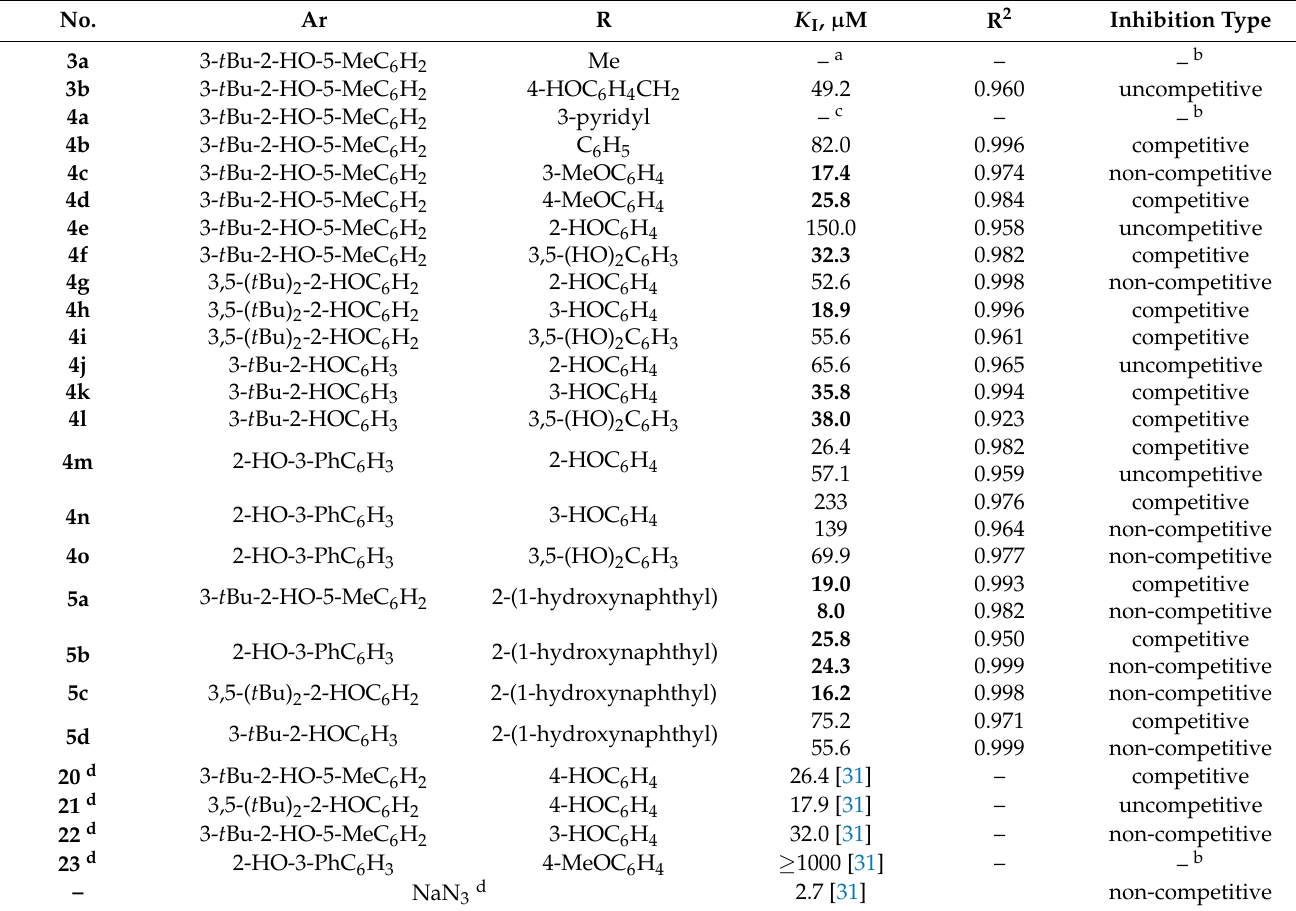
Table 2. Structures and inhibition constant ( K I , µ M) values of the hydrazide-hydrazones 3a – b , 4a – o , 5a – d determined for laccase ( T. versicolor ). Crucial K I values were bolded. The reference compounds are 20 – 23 and NaN 3 [31].